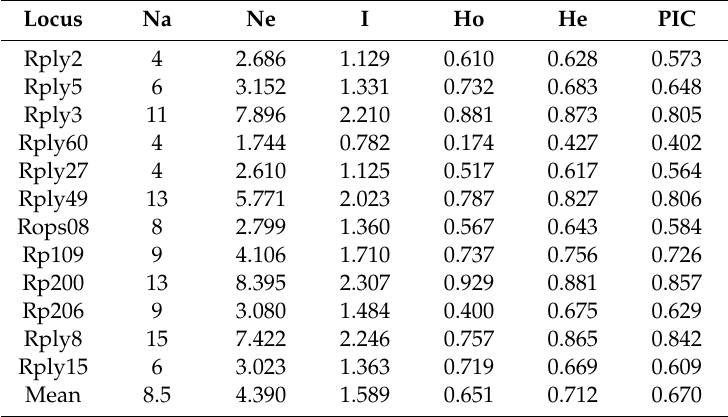
Table 4. Indices of polymorphism obtained for 123 black locust cultivars with 12 SSR markers. Locus Na Ne I Ho He